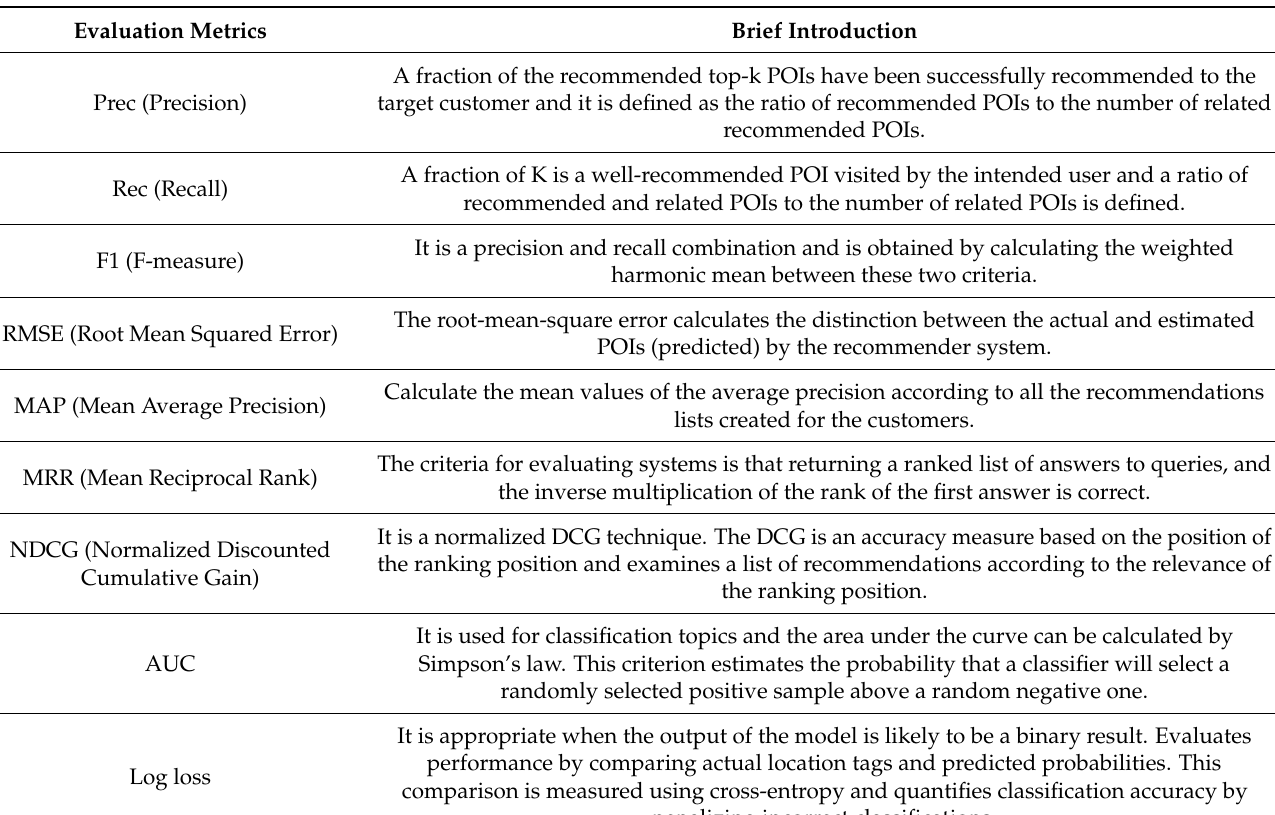
Table 2. A short description of the most widely employed evaluation metrics in selected